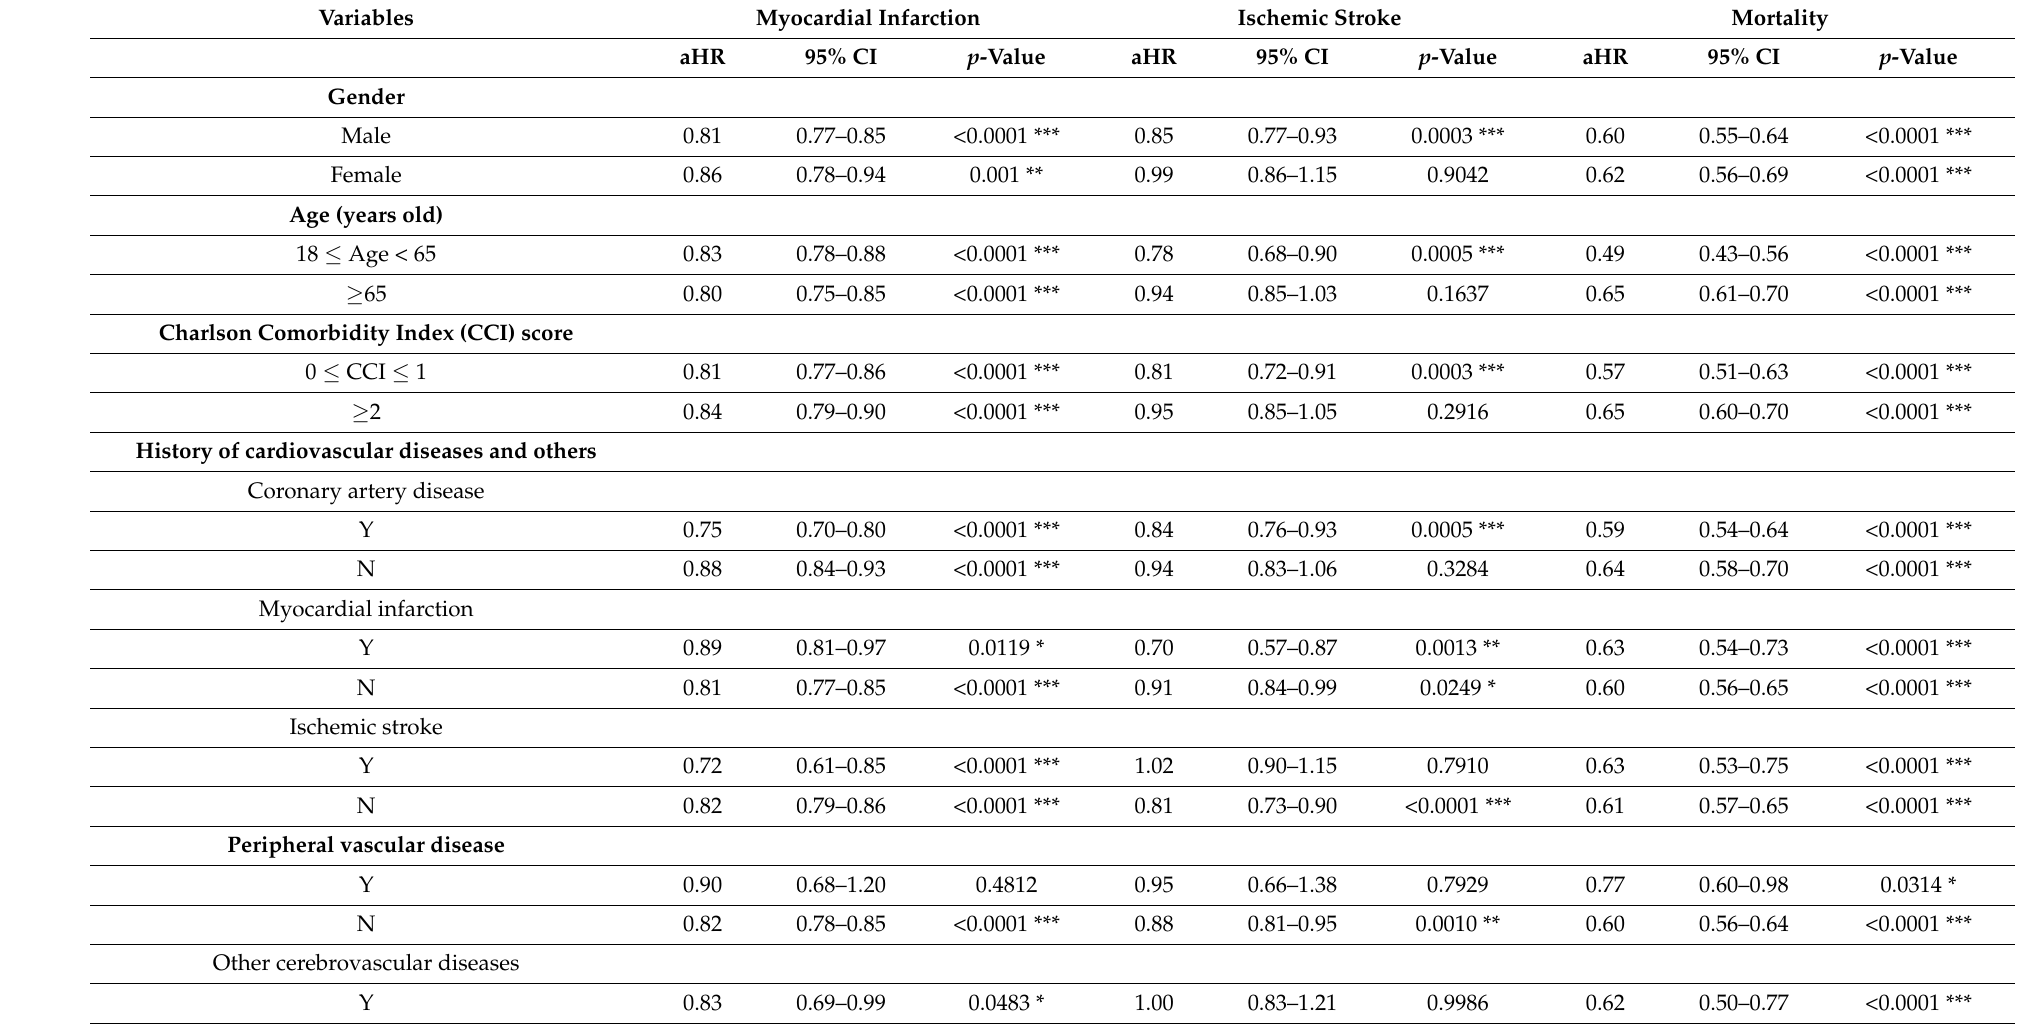
Table 3. Results of the Cox proportional hazard model with subgroup of DES vs. BMS